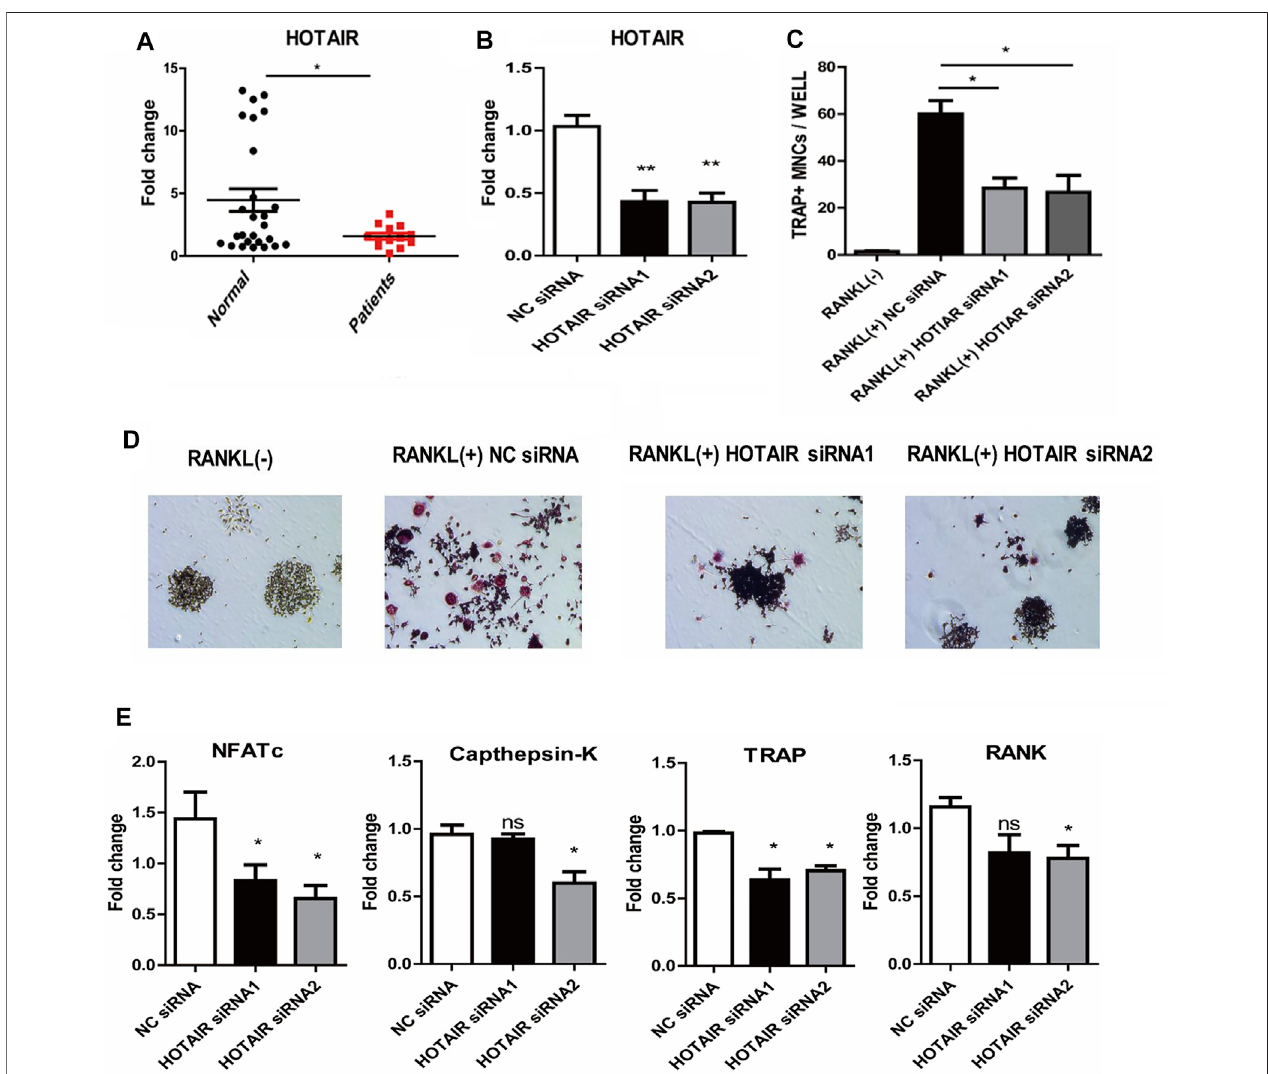
FIGURE 1 | The phenotype of HOTAIR in PBMCs of patients, and knockdown of HOTAIR decreases the RANKL-induced osteoclast differentiation in RAW 264.7 cells (A) ThelevelsofHOTAIR weresigni fi cantlylowerinPBMCsofpatientswithcraniosynostosis(N=13)compared tonormalpeople(N=26) (B) Detection ofHOTAIR expressioninRAW264.7cellswithHOTAIRknockdownbytwodistinctsiRNA(200 nM),NC:negativecontrol (CandD) RAW264.7cellsweretreatedwithRANKLand M-CSF for 5 days. Cells were fi xed and stained for TRAP. TRAP + cells with more than three nuclei were counted as osteoclasts. Magni fi cation: ×100. TRAP + cells were counted (E) The effects of HOTAIR knockdown on mRNA levels of osteoclast differentiation-related genes. Bars represent the mean ± SEM. * p < 0.05, ** p < 0.01. The data are representative of three independent experiments.